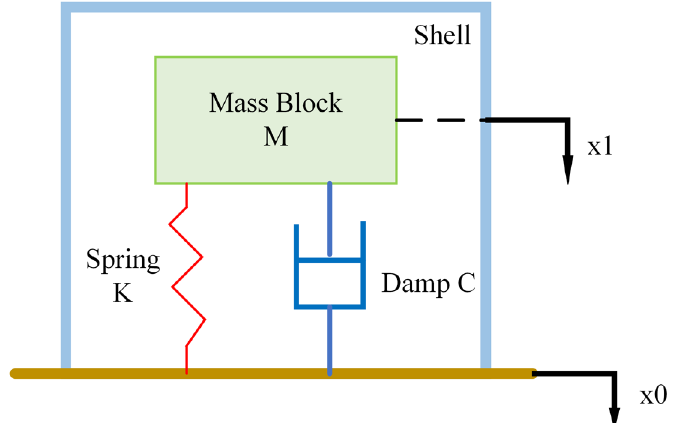
Figure 1. Sensor dynamics model.